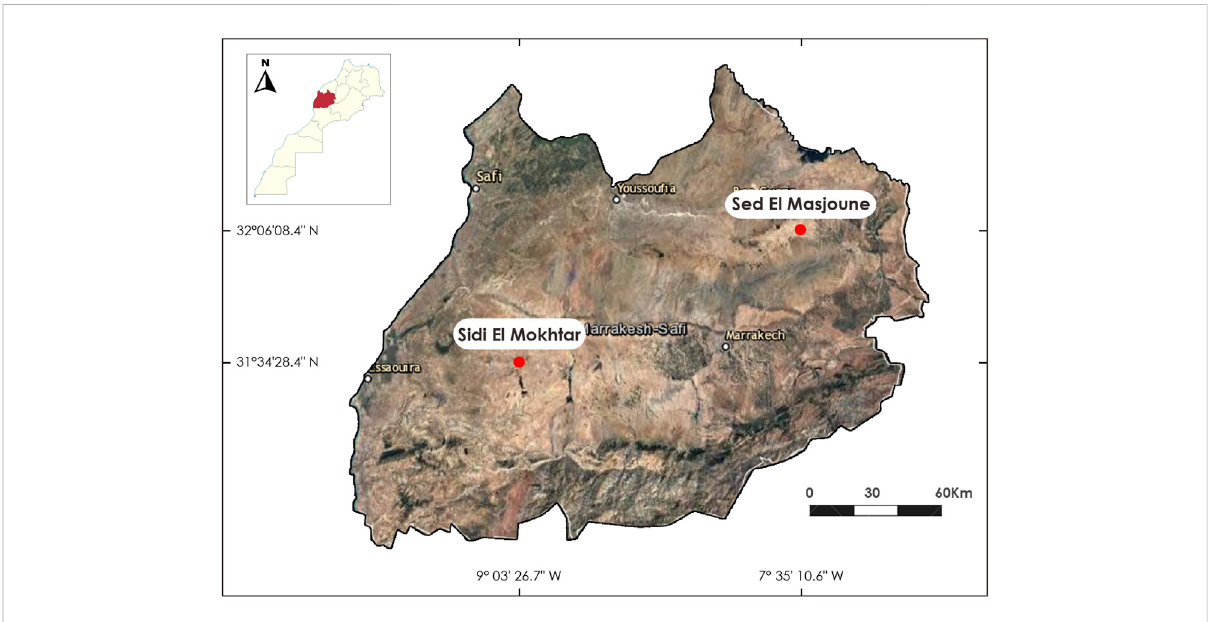
FIGURE 3 Location of collected